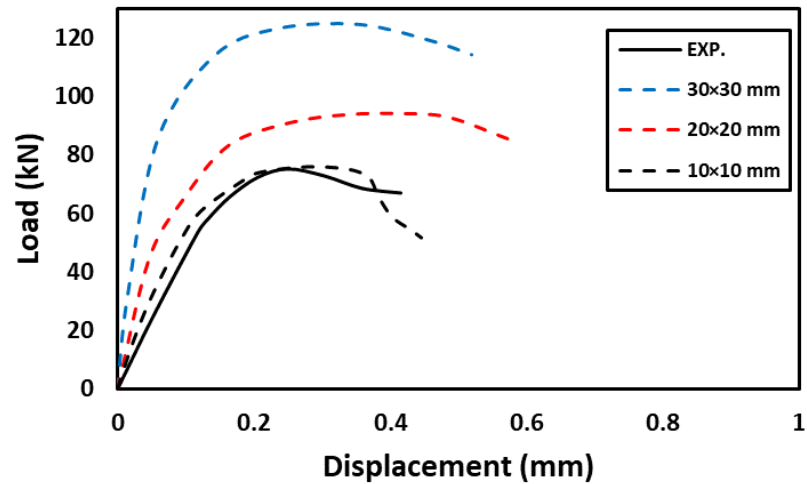
Figure 19. The effect of mesh size on the load – displacement curves of NC specimens.